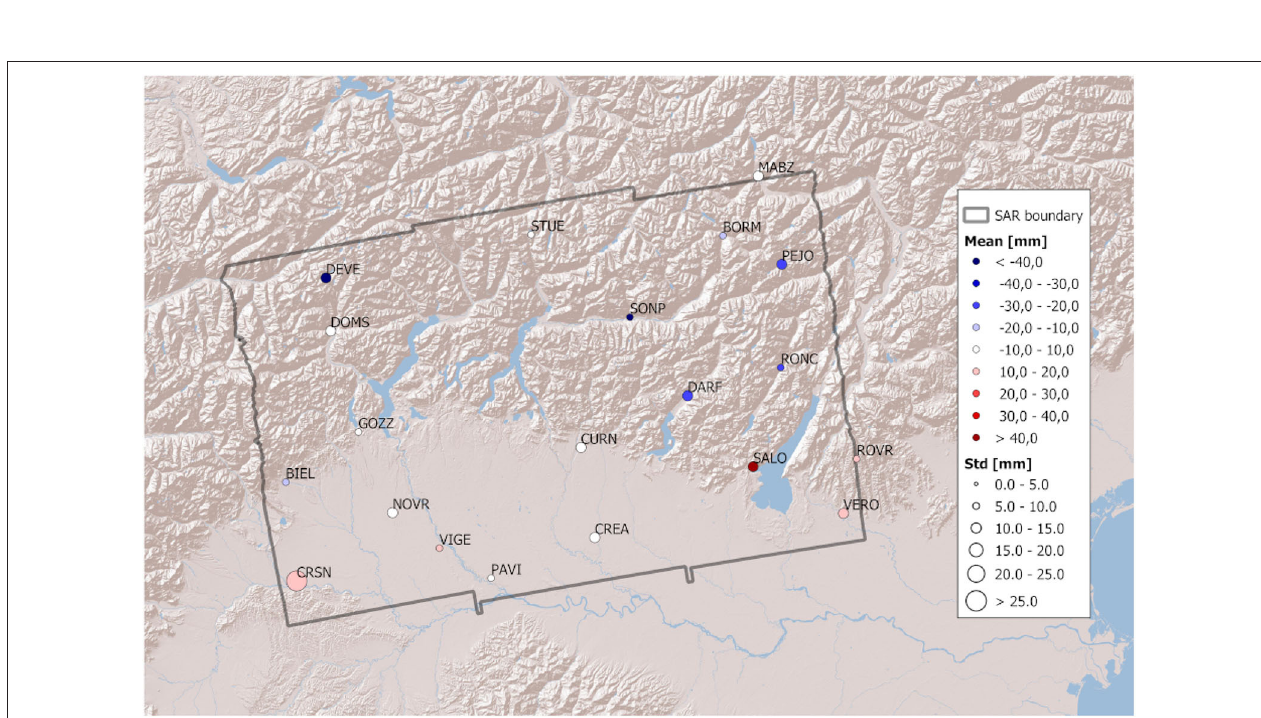
FIGURE 12 | Map of the temporal statistics of the difference between 3DVAR ZTD and GNSS ZTD.